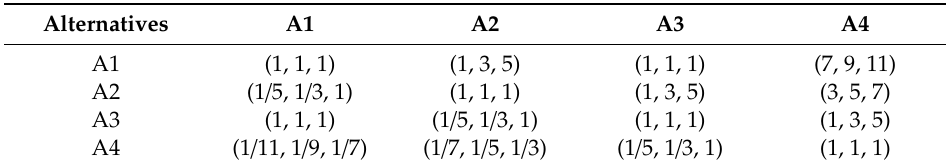
Table 9. Evaluation with respect to e ff